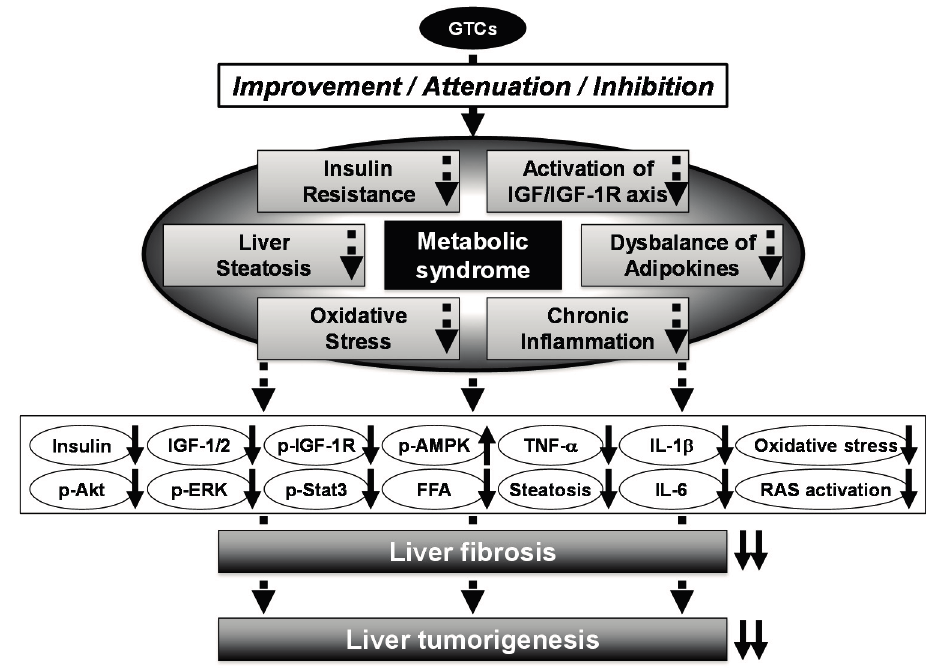
Figure 2. Mechanisms of action of GTCs in the inhibition of metabolic syndrome-related liver carcinogenesis. Metabolic syndrome significantly increases the risk of HCC development. Several pathophysiological mechanisms link metabolic syndrome and liver carcinogenesis, such as insulin resistance, activation of the IGF/IGF-1R axis, chronic inflammation, oxidative stress, and adipokine dysbalance. They appear to be followed by molecular abnormality, including activation of PI3K/Akt and MAPK/ERK signaling, down-regulated phosphorylated-AMPK, and increased pro-inflammatory cytokines. Administration of GTCs significantly reduces the risk of HCC development in obese patients, and this might be associated with decreased insulin resistance and hepatic steatosis, inhibition of the activation of the IGF/IGF-1R axis, and attenuation of oxidative stress and chronic inflammation. Up- and down-pointing solid arrows mean items are up- and down-regulated,